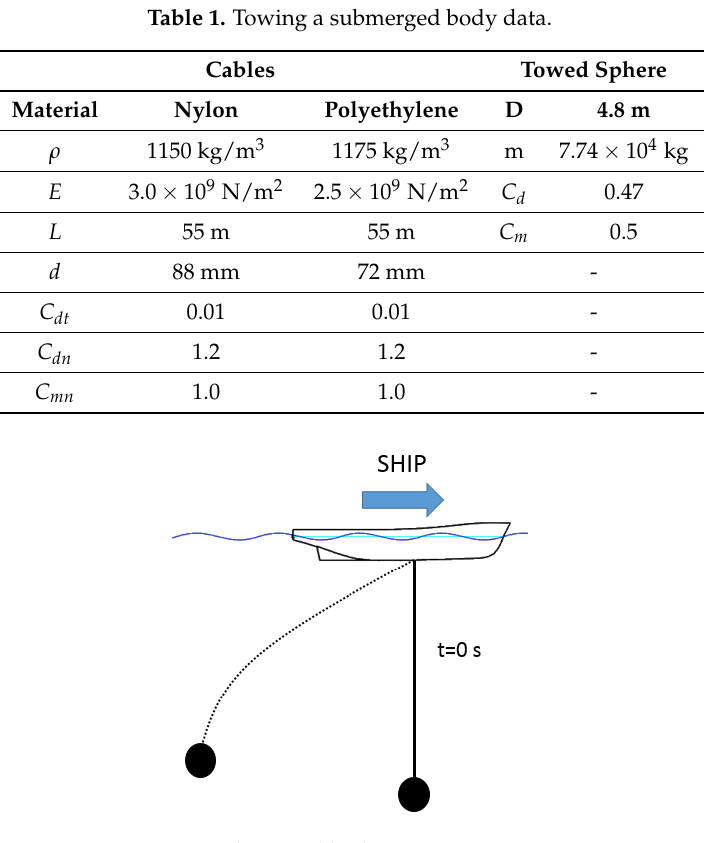
Figure 15. Submerged body towing system set